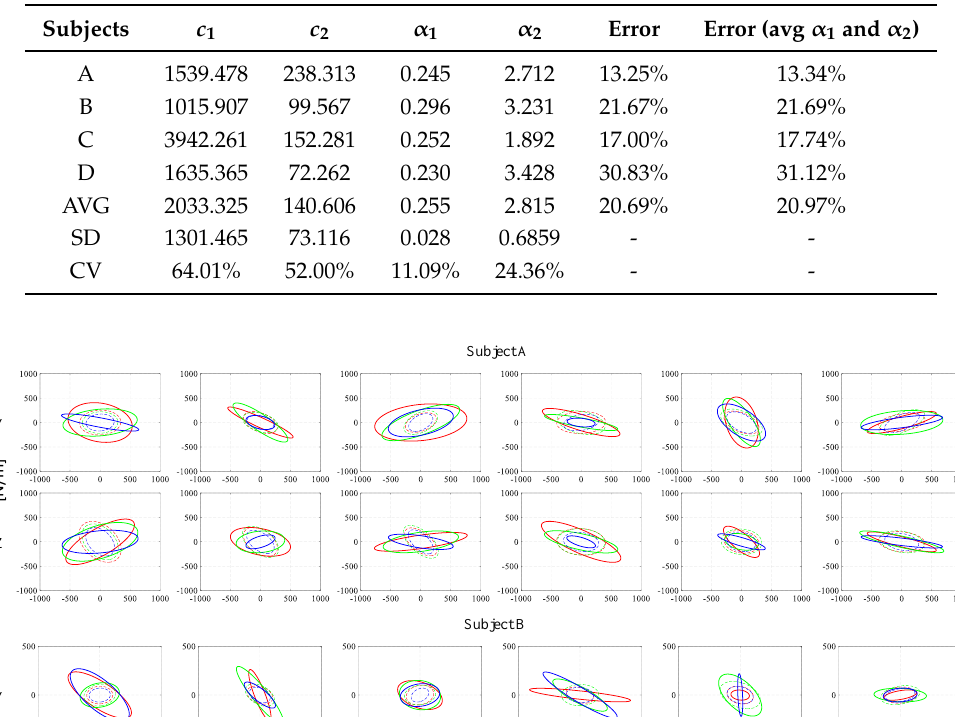
Table 1. Model parameters’ identification results.